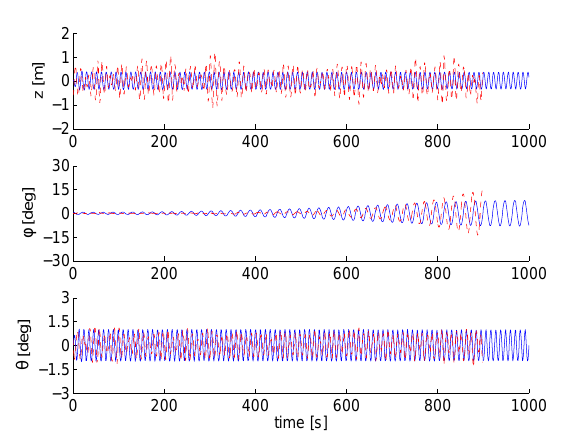
Figure 8: Exp. 1180. Exp. dashed red, sim. solid blue.